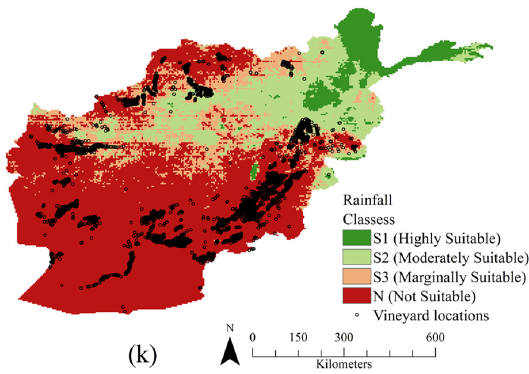
Figure 4. Reclassification of the criterion used for suitability analysis ( a – k ).